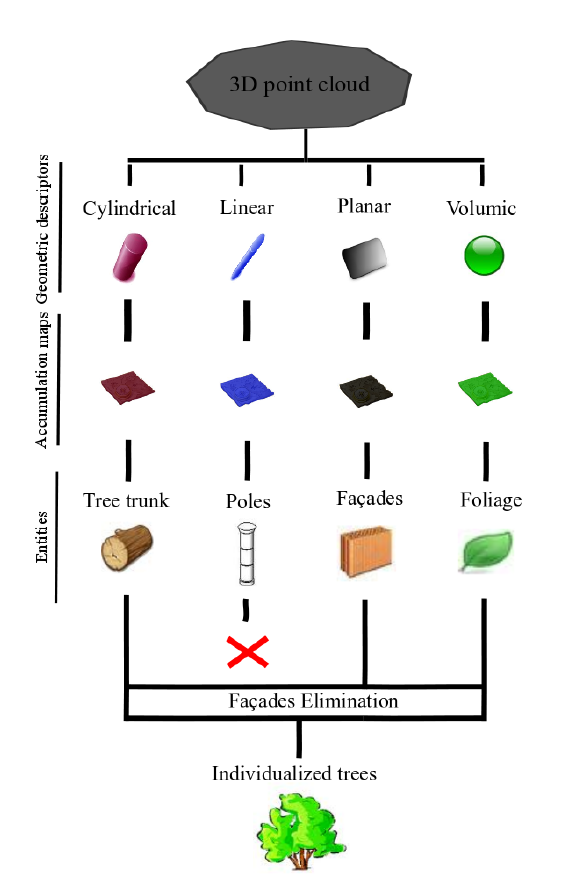
Figure 2: Overview of our tree detection method.